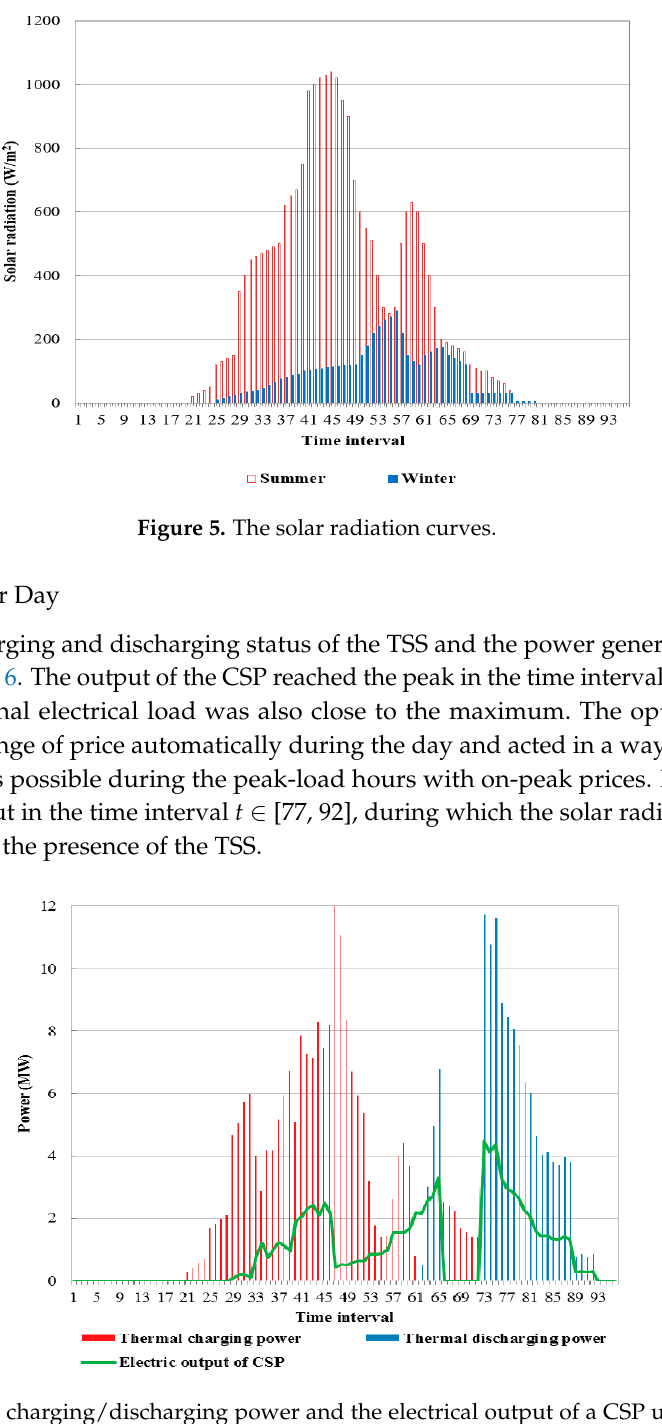
Figure 7. Shiftable electrical loads on a typical summer day. Figure 8. Heating power of the water storage tank and the temperature of hot water on a typical summer day.